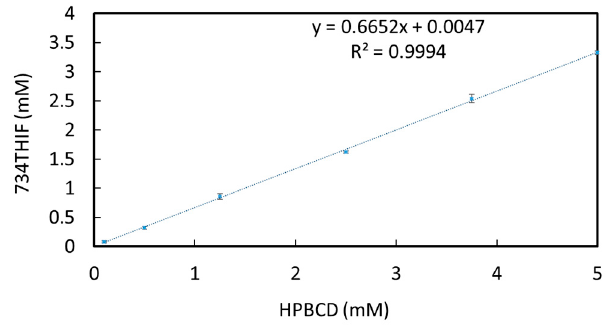
Figure 1. Phase solubility diagram of 734THIF-HPBCD system.